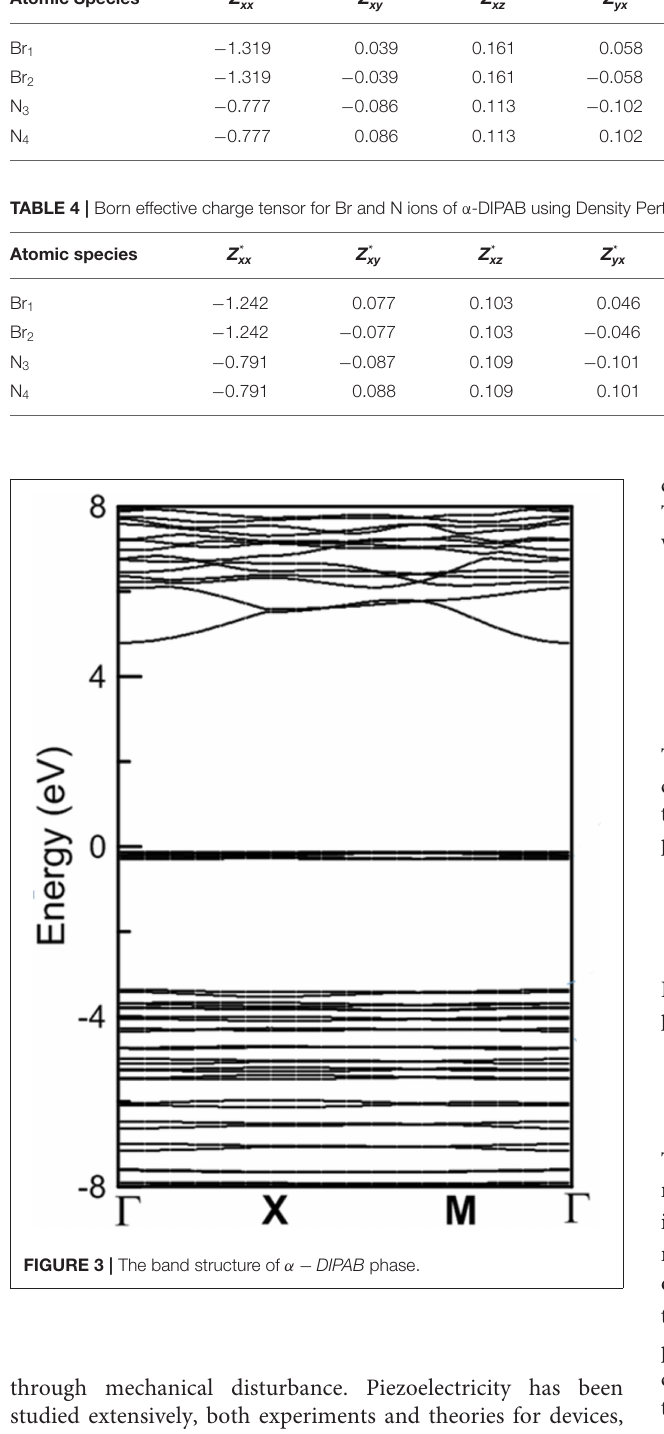
TABLE 3 | Calculated Born effective charge tensor of bromine and nitrogen atoms of α -DIPAB calculated by applying a homogenous electric field + 0.01 ˆ z eV/. Atomic Species